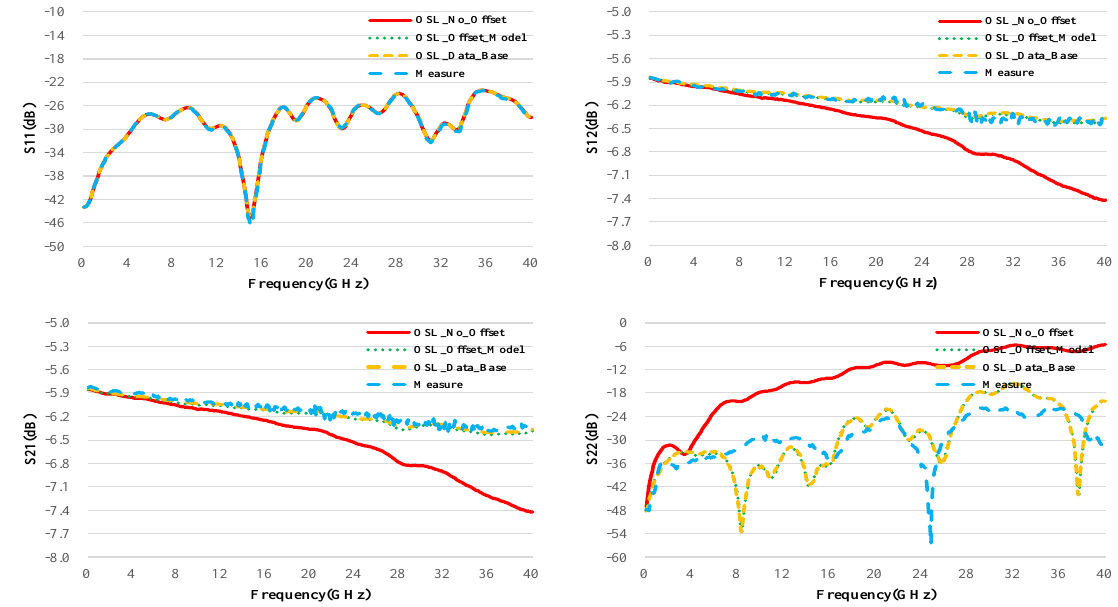
Figure 4. S-parameter magnitude of the 6 dB attenuator (Weinschel ® 75A-06, Weinschel, Frederick, MD, USA).